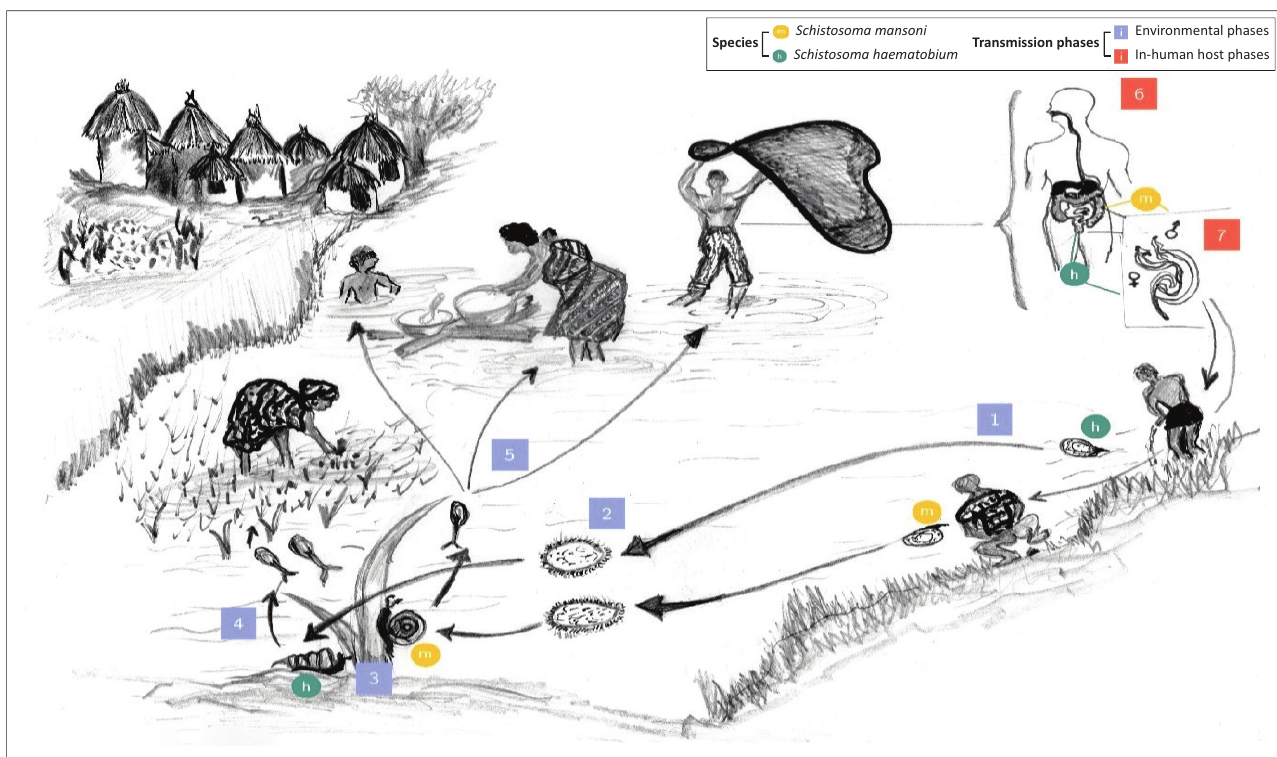
FIGURE 1: Overview of the various activities associated with Schistosoma haematobium (green circles) and Schistosoma mansoni (yellow circles) TABLE 1: Estimates of the South African population requiring preventive chemotherapy for schistosomiasis. Year